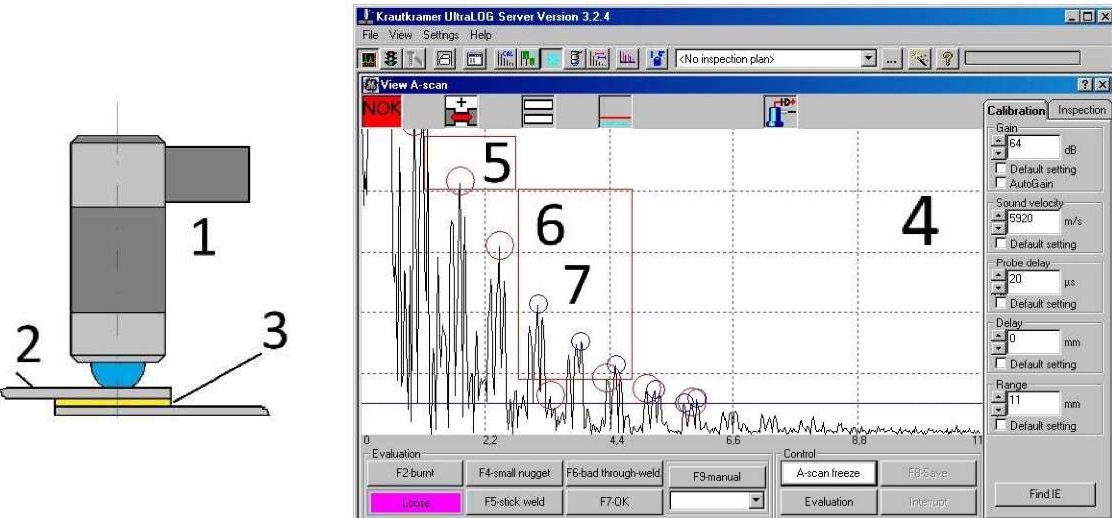
Figure 9. Ultrasonic testing; 1—ultrasonic probe; 2—stell DC01; 3—adhesive; 4—ultrasonic flaw de- tector screen; 5—first echo on the flaw detector screen (in this case H I = 80 %); 6—second echo on the flaw detector screen (in this case H II = 40 %); 7—third echo on the flaw detector screen (in this case H III = 9 %).